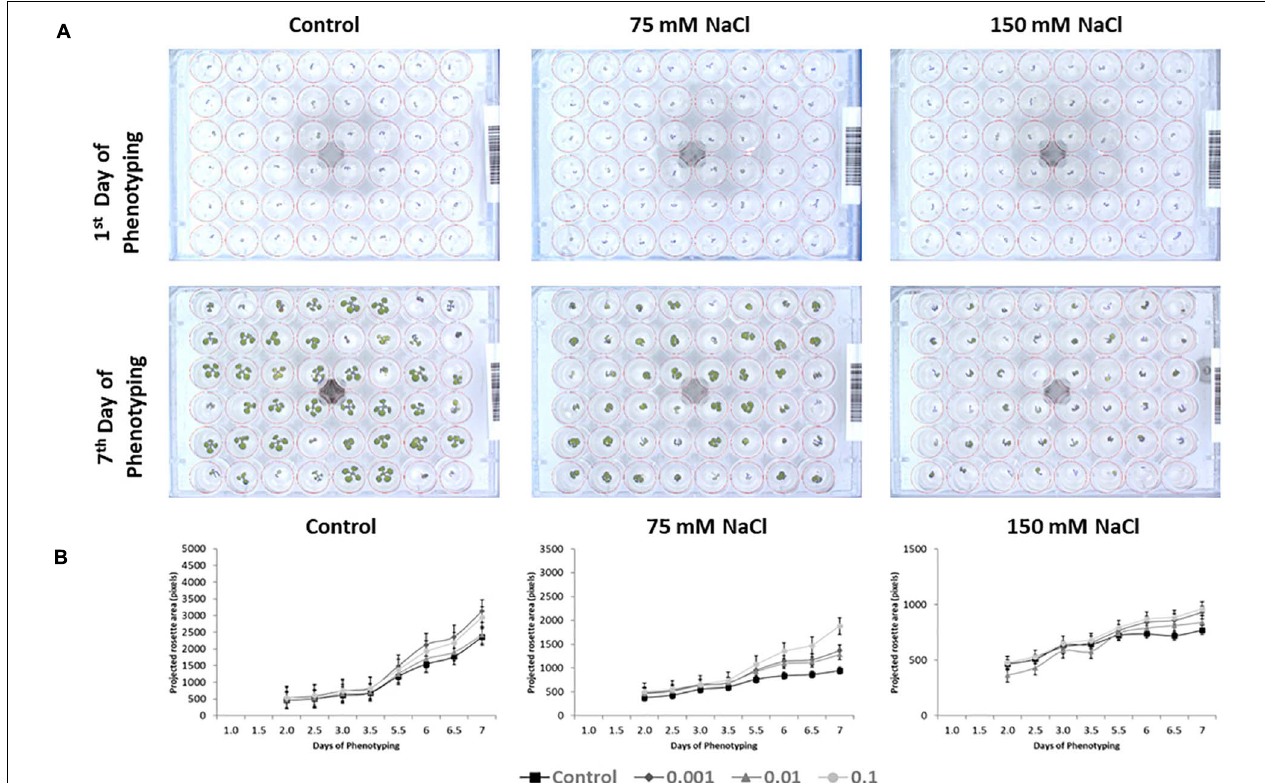
FIGURE 3 | Top view RGB pictures of the 48-well plates and projected rosette area (pixels) of seedlings from seeds primed with D compound (Trainer (cid:114) ). RGB image of an individual 48-well plate at the first and the last day of the experiment, containing non-primed Arabidopsis seedlings or primed with the “D” product grown under non-saline, 75 or 150 mM NaCl conditions (A) . Increase in projected rosette area (pixels) throughout the 7 days of the experiment for the same seedlings primed with D product (Trainer R (cid:13) ) grown under non-saline, 75 or 150 mM NaCl conditions (B) . The values represent the average of the 96 biological replicates per treatment, error bars represent SE